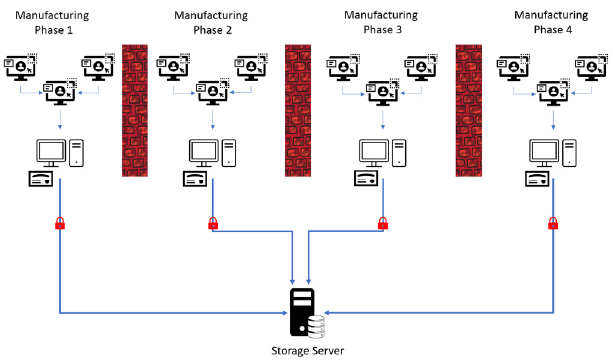
Figure 15. Zero-Trust security architecture without any implicit trust .